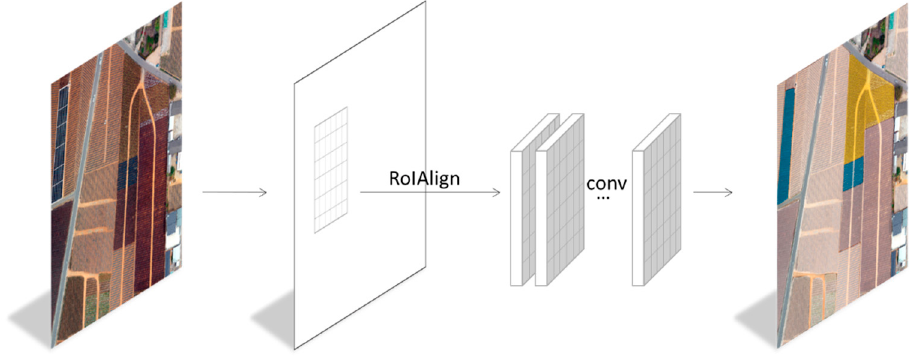
Figure 5. The framework of Mask R-CNN in this study.